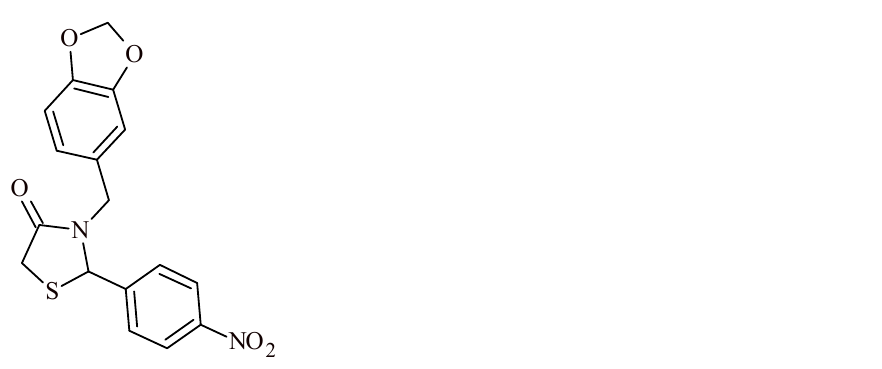
Figure 39. The structure of 3-(benzo[ d ][1,3]dioxol-5-ylmethyl)-2-(4-nitrophenyl)thiazolidine-4-one.